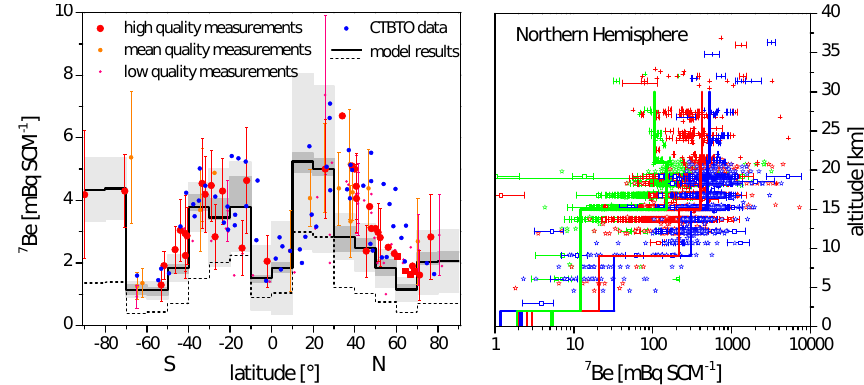
Figure 1. Model validation using global observations of the 7 Be activity air concentration (SCM is standard cubic meter). Left: model– measurement comparison of mean 7 Be activity concentrations in boundary layer air. Different sizes and colors of measurements (circles and squares) denote different quality of long-term mean values: high quality (time series longer than 10 years, >10 months of data per year on average), mean quality (time series longer than 3 years, >9 months of data per year on average) and low quality (shorter time series and literature data without details on sampling time); circles denote mean values and squares represent median values. Note that all elevated sites (>1000ma.s.l.) except South Pole station at 90 ◦ S are excluded. Blue symbols show unpublished data from the global CTBT monitoring system. These data allow for an independent model validation since sampling sites do not coincide with data used for model calibration. Model results are shown as black lines and grey shaded areas. Solid and dashed lines denote model results based on 7 Be production rate calculations by Usoskin and Kovaltsov (2008, solid line) and Masarik and Beer (2009, dashed line). The dark grey band indicates the model uncertainty from aerosol sink calibration. Light grey bars denote the standard deviation of the model results dominated by the seasonal cycle of the atmospheric concentrations. Model results encompass the mean of AD1950–2000, whereas measurements represent various periods. Right: vertical distribution of 7 Be in the northern atmosphere according to US EML high-altitude sampling program data (symbols) and the GRACE model (lines) based on Usoskin and Kovaltsov (2008) production rates. Different colors denote different latitudinal bands according to the model resolution: polar (blue; 60–90 ◦ N), mid-latitude (red; 30–60 ◦ N) and tropical (green; 0–30 ◦ N). Different symbols represent the three different high-altitude sampling programs: stars (STAR DUST), squares (AIRSTREAM) and crosses (ASHCAN). Data: Kolb (1992); Durana et al. (1996); Megumi et al. (2000); Ioannidou et al. (2005); Wershofen and Arnold (2005); Kulan et al. (2006); Kulan (2007); Feely et al. (1981, 1985, 1988); Larsen and Sanderson (1990, 1991); Larsen et al. (1995); Feely et al. (1967); Leifer and Juzdan (1986); Leifer (1992); Chae et al. (2011); Elsässer et al. (2011); Leppänen et al. (2012); Doering (2007), and references